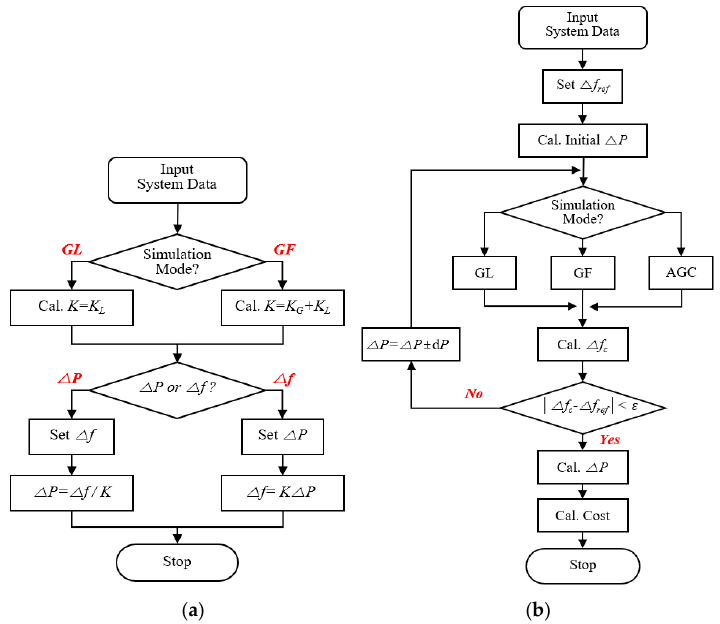
Figure 7. Flow chart of steady-state and transient-state analysis: ( a ) Steady-state analysis; ( b ) Transient-state analysis.